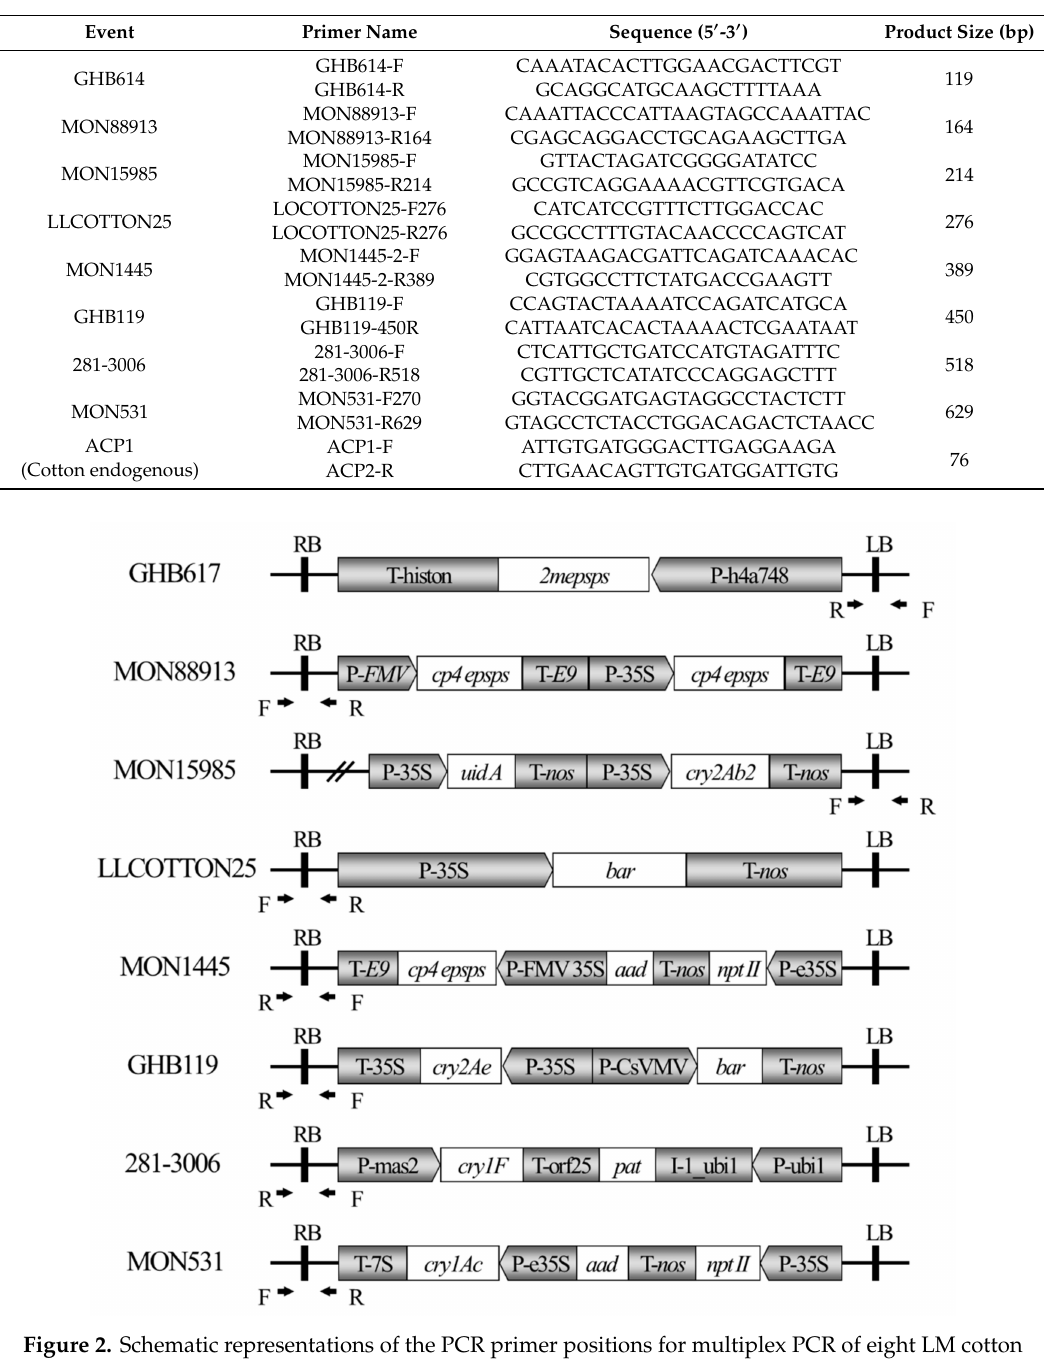
Table 1. New oligonucleotide primers used to detect eight LM cotton events.